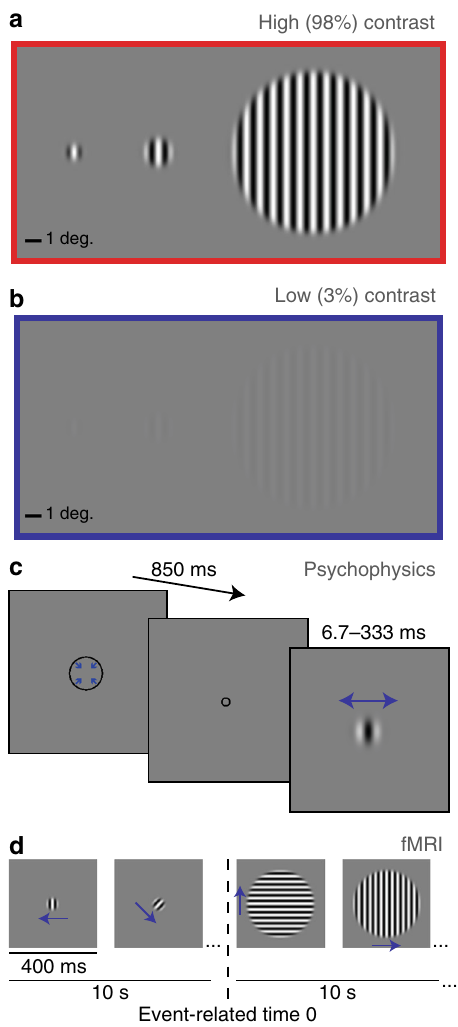
Fig. 1 Stimuli and paradigms. a Small (0.84°), medium (1.7°), and big gratings (10° diameter) at high contrast (98%). b The same gratings at low contrast (3%). c Psychophysical paradigm: a fi xation mark (shrinking circle) was followed by a brie fl y presented drifting grating (left or right; small high- contrast grating shown). Blue arrows indicate direction of motion. d fMRI paradigm: alternating 10 s blocks of smaller (2°) and larger (12°) gratings (high contrast shown). Vertical dashed line indicates the transition from smaller to larger, which is the event of experimental interest. Note that stimuli are scaled differently across panels for display